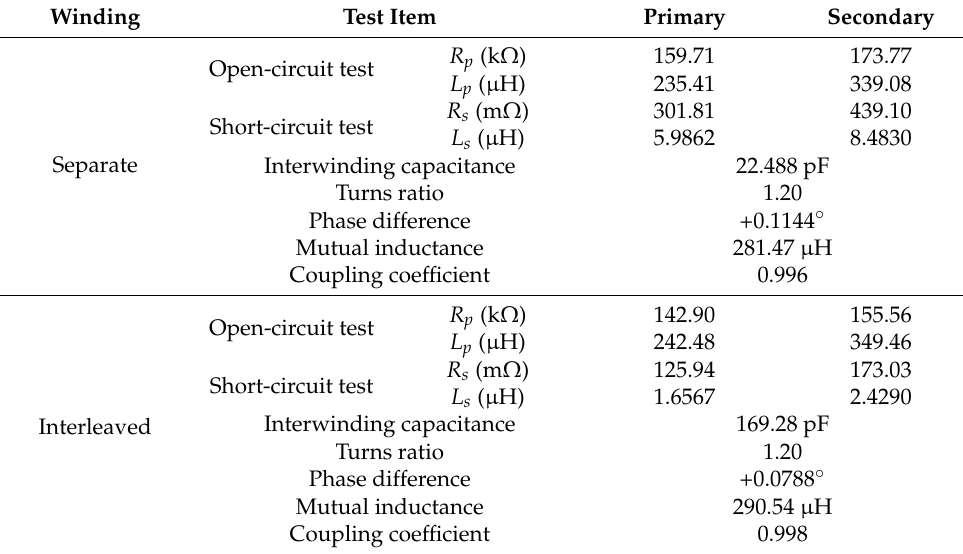
Figure 17. Schematic of two different winding structures: ( a ) Separated; ( b ) Interleaved. The prototype HF transformer with separate and interleaved winding structures underwent impedance testing at various frequencies from 10 kHz to 200 kHz using an R&S ® HM8118 LCR meter with an HZ186 four-terminal transformer test fixture. Table 9 provides a summary of impedance testing measurements at 100 kHz, and Table 10 presents the comparison between the measured and simulated circuit inductances of the prototype HF transformer with a separate winding structure. The circuit inductances and interwinding capacitances of both winding structures obtained from impedance testing are shown in Figure 18. Table 9. Impedance measurements of the prototype HF transformer with separate and interleaved winding structures at 100